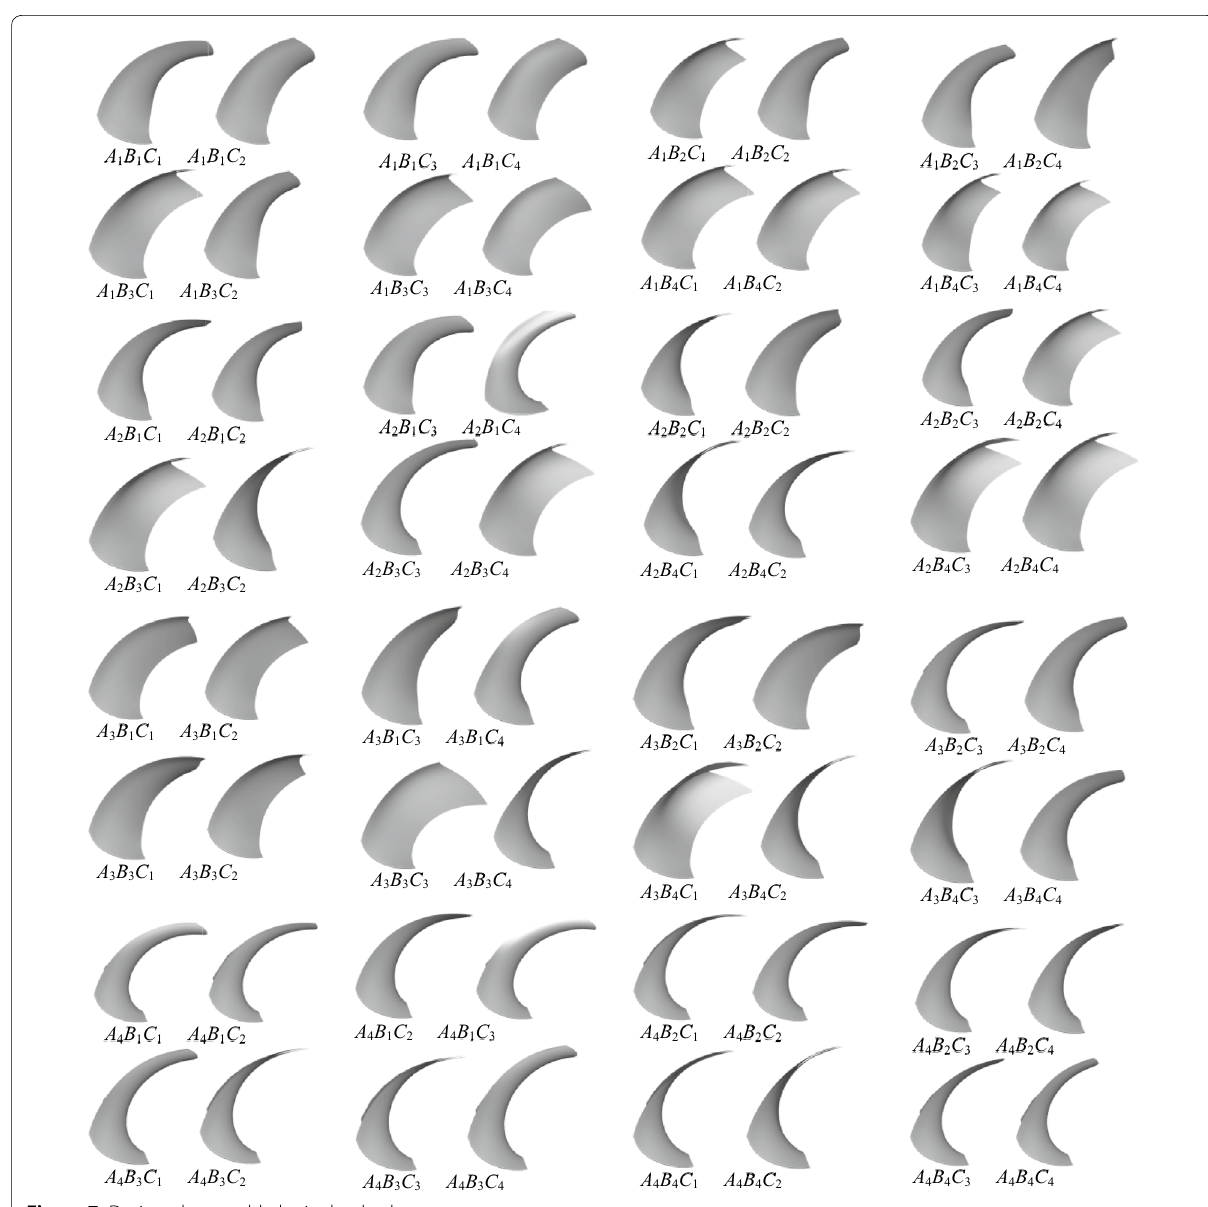
Figure 7 Designed runner blades in the